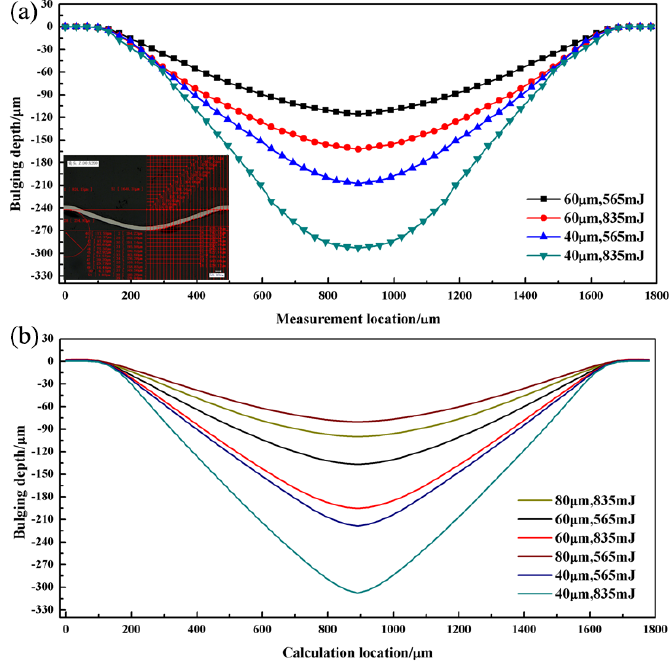
Figure 8. The depth of the micro bulging parts ( a ) experimental results ( b ) simulation results.